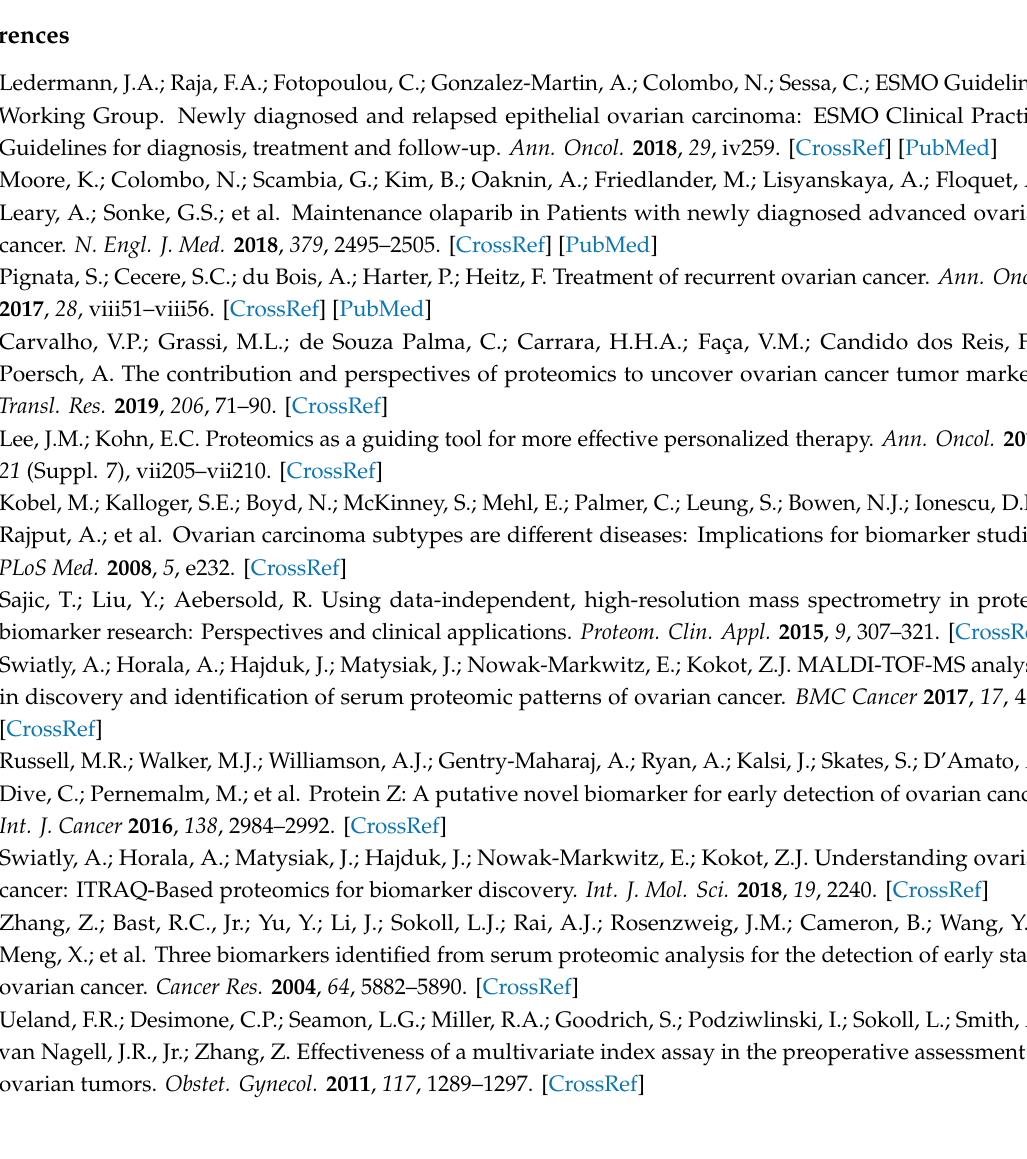
the 34 samples from the development cohort. Table S8: Concordance table of test classifications between plasma samples and serum samples for 37 patients in the development cohort. Table S9: PSEA assessment of association of test classifications with various biological processes. Table S10: Points in m / Z used to align the raster spectra. Table S11: Regions of spectrum used for first coarse normalization. Table S12: Regions of spectrum used for second normalization. Table S13: m / Z positions used for alignment. Table S14: m / Z regions (features) used for final normalization. Table S15: Definitions of features used in classifier development. References [52–55] are cited in the supplementary